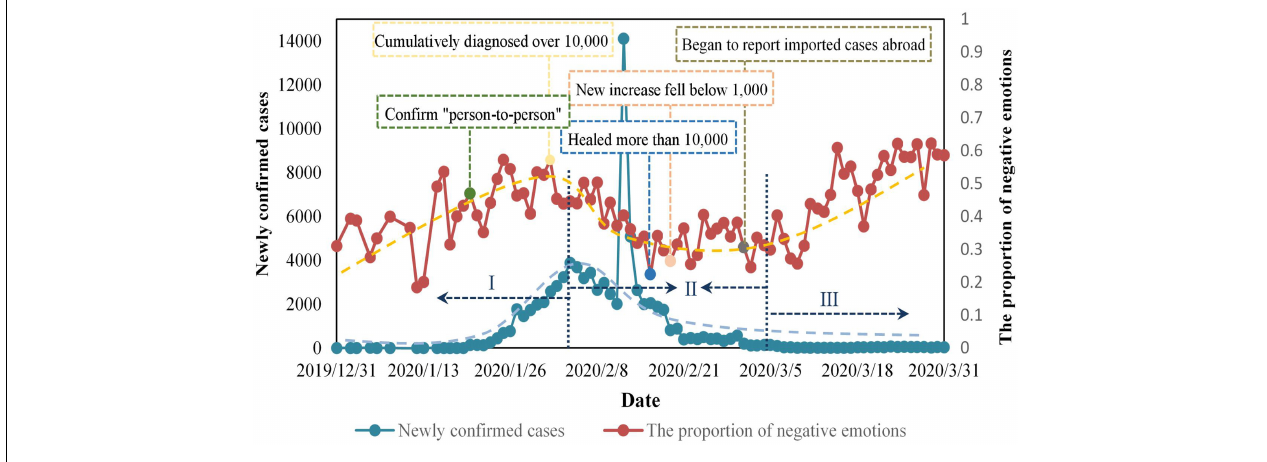
FIGURE 5 | Changes in the proportion of people’s negative emotions and the number of newly confirmed cases.